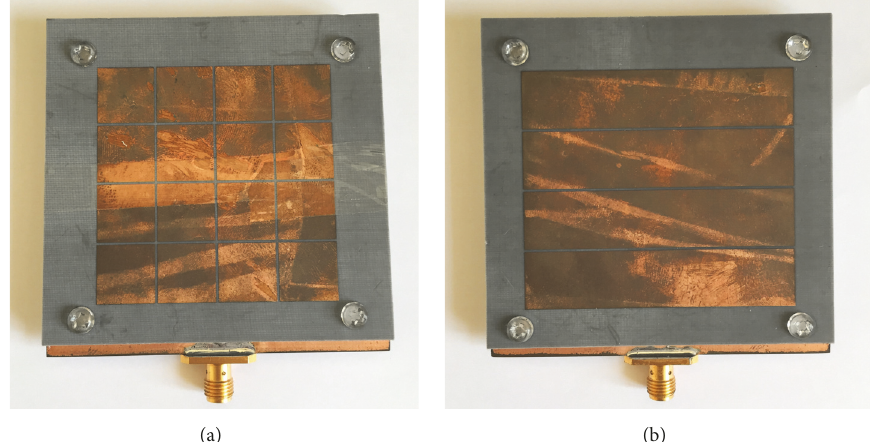
Figure 8: Photo of two planar MP antennas. (a) MP II composed of 4 × 4 rectangular patch cells. (b) MP III composed of 1 × 4 rectangular patch cells.